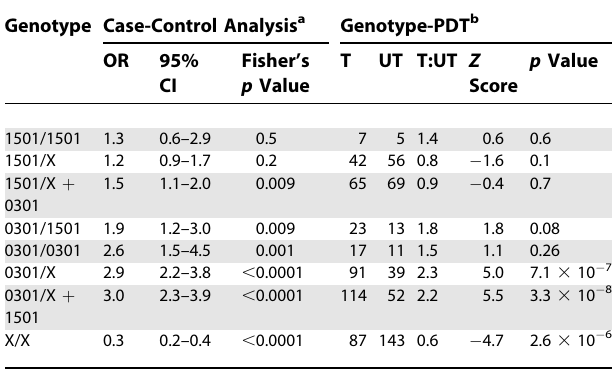
Table 3. Genotype-Pedigree Disequilibrium Test for SNP rs419788 in 281 UK SLE Trios